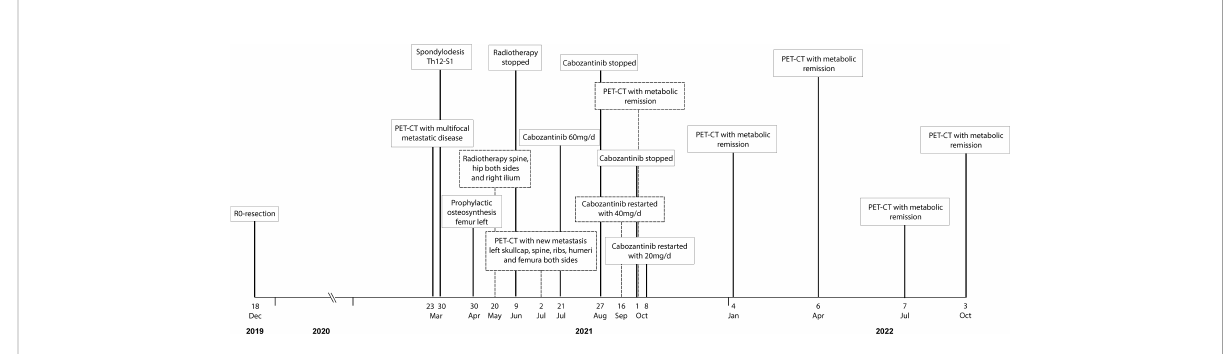
FIGURE 3 Detailed timeline showcasing relevant data from the episode of care.